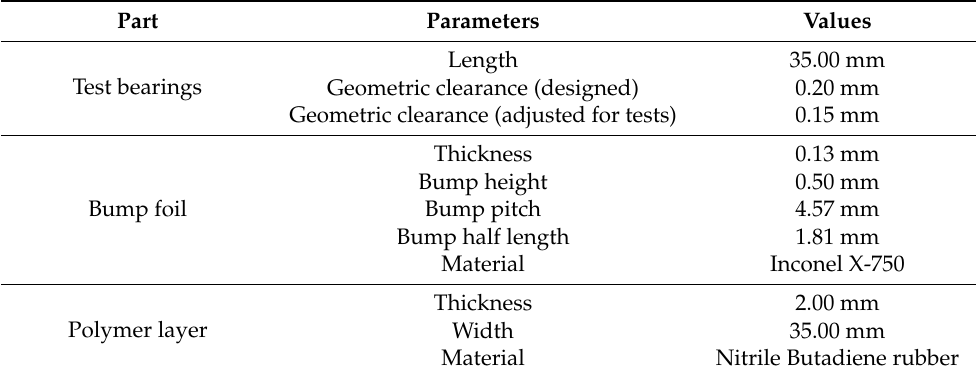
Table 1. Test bearing design